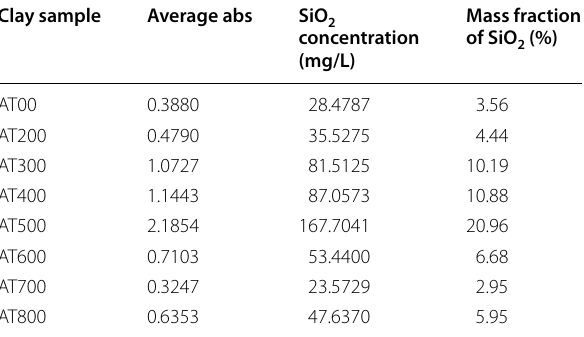
Table 3 Absorption and SiO SiO of attapulgite solution. 2